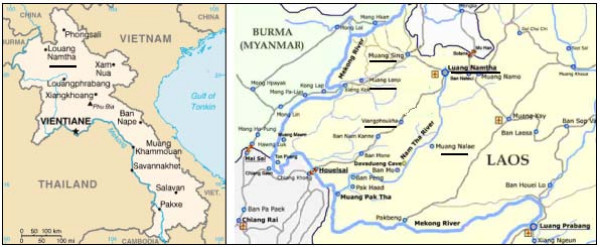
Map of the study area: Luang Nam Tha Province, North of Laos.